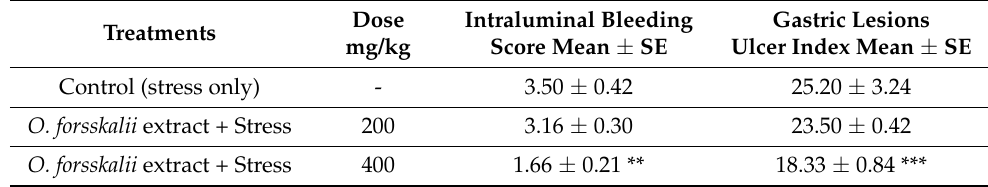
Table 3. Effect of the O. forsskalii extract on hypothermic-restrained stress-induced intraluminal bleeding and gastric lesions in